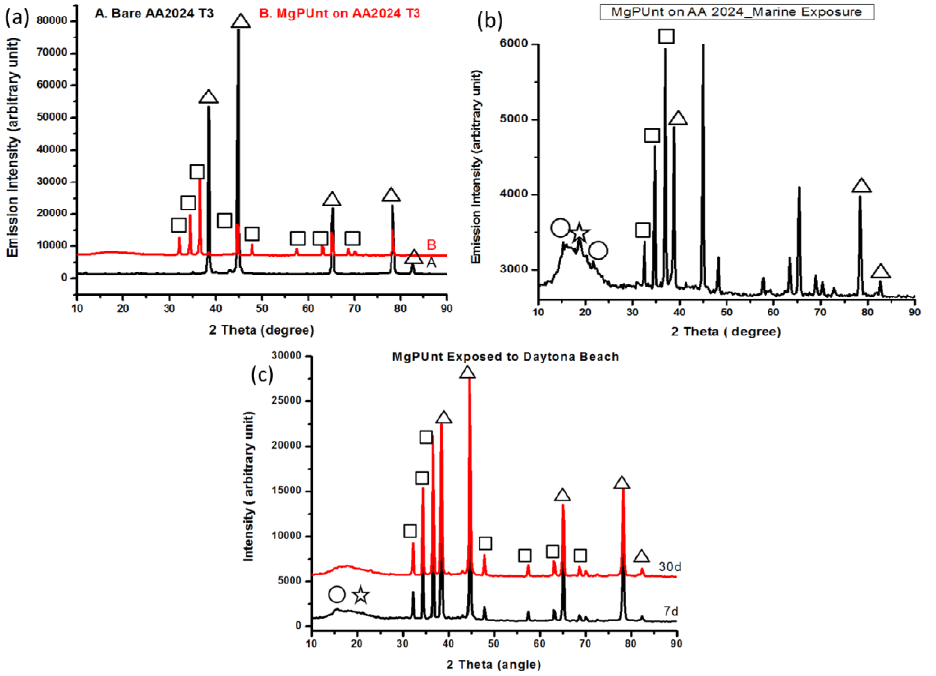
Figure 4. X-ray patterns of bare AA2024-T3 and MgPUnt on AA2024-T3 ( a ), MgPUnt on AA2024-T3 exposed at Hawaii (marine exposure) ( b ), and MgPUnt exposed at Daytona (brucite); ( ☆ ) hydroxy Mg carbonate beach. Florida ( c ). Phases identified: ( ○ ) Mg(OH) 2 (nesquehonite); ( □ ) Mg; and ( ∆ )